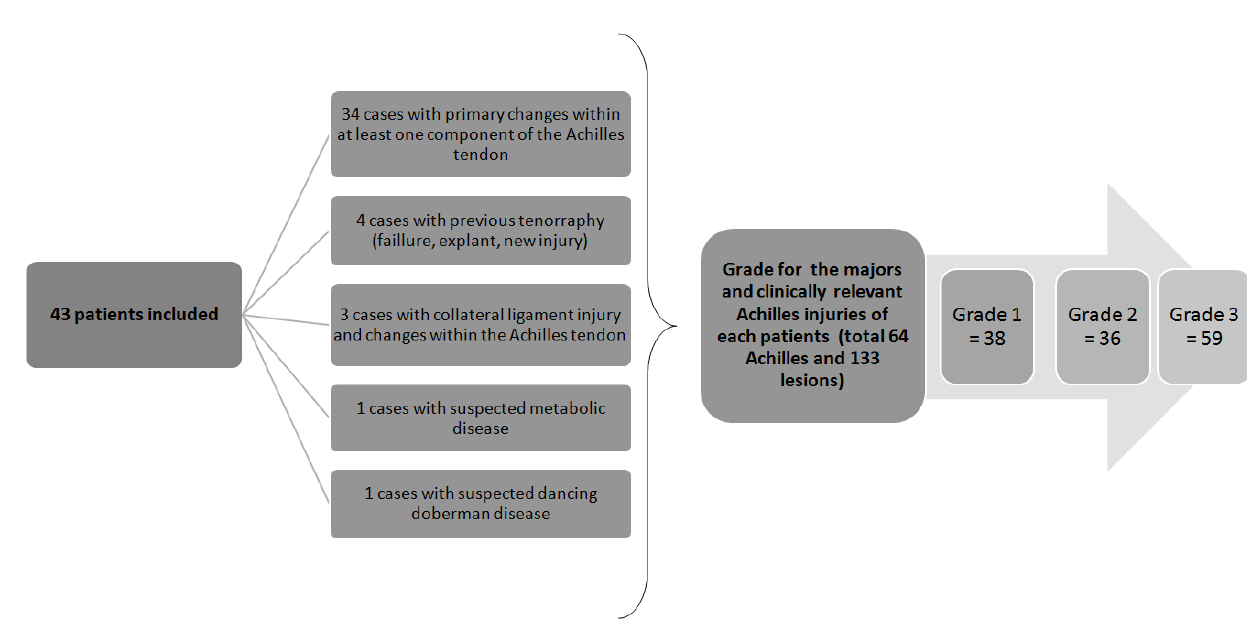
Figure S2 : Organigram of the Patients Included Based on the Diagnostic Ultrasound Results *The number of lesions analy s ed within each grading categories of strain is not additive and does not correspond to the number of patients included in this study. One patient may have had injuries to multiples components of the Achilles tendon which were graded separately and changes may have been bilateral. 43 patients were included in this study, 64 Achilles tendons had ultrasonic abnormalities but a total of 133 lesions were